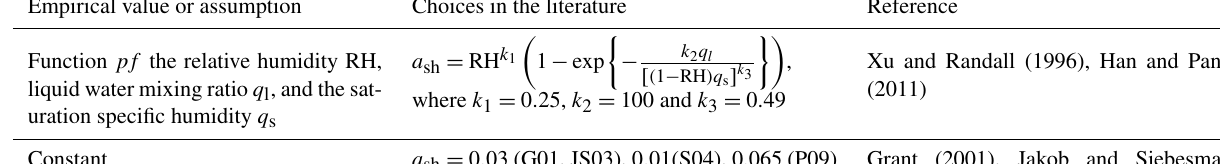
Table 15. A sample of empirical values and assumptions used in the cloud fraction (note: subscript “sh” refers to shallow convection). Empirical value or assumption Choices in the literature